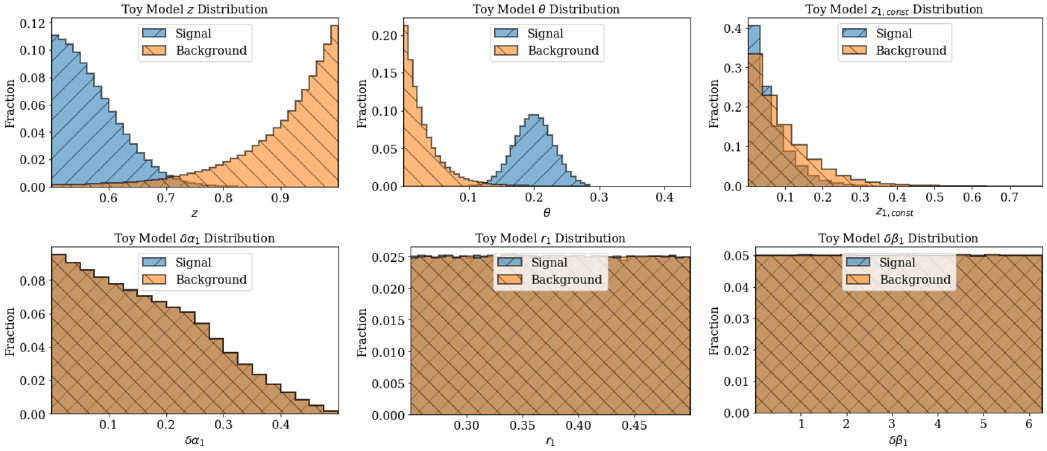
Figure 3. The normalized z , θ distributions for signal and background events in the Toy Model, along with the z 1 , δα 1 , δβ 1 , and r 1 values for those same